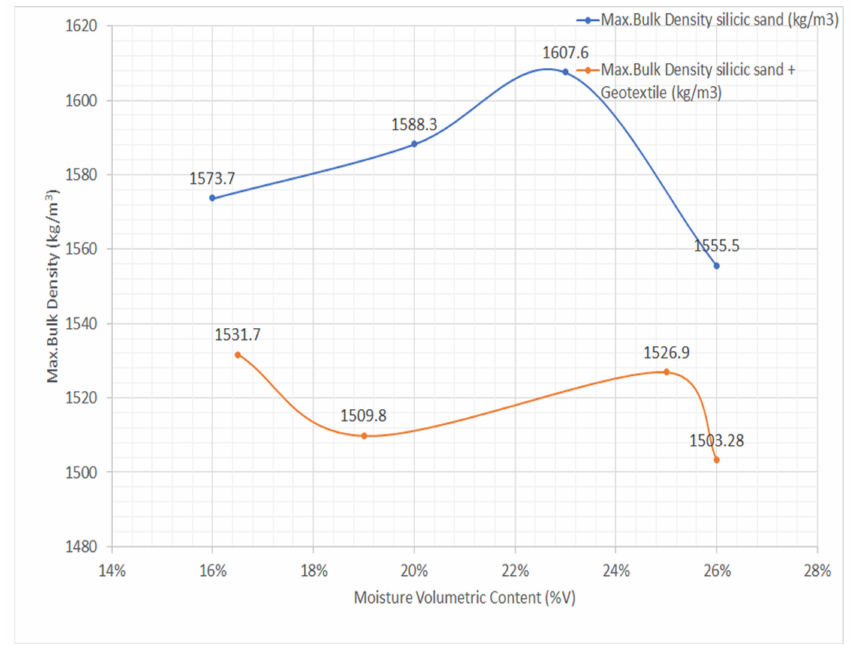
Figure A2. Bulk density of silicic sand and silicic sand and geotextile addition (2 kg/m 2 ) with volumetric moisture content (kg/m 3